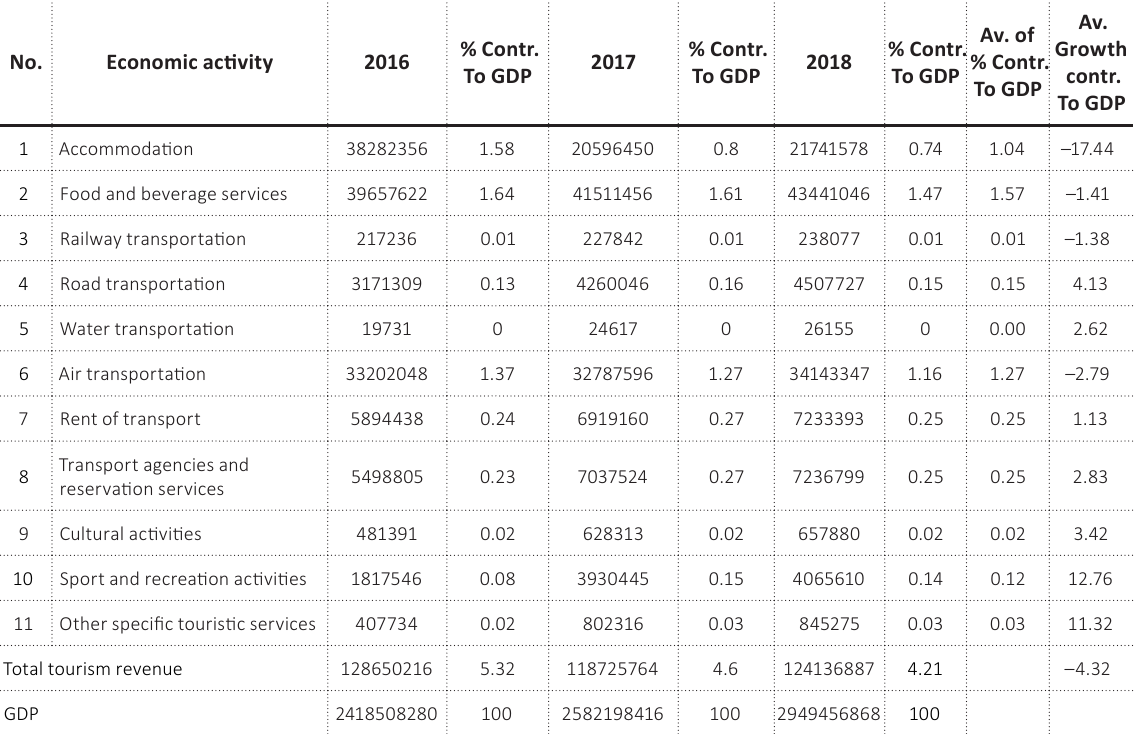
Table A3. Contribution trend of tourism revenue avenues to GDP of Saudi Arabia (million Riyals)